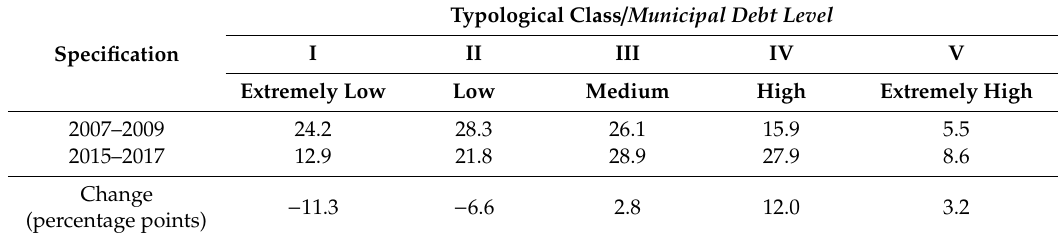
Table 4. Typological classification of the Polish rural municipalities by level of debt in 2007–2009 and in 2015–2017.